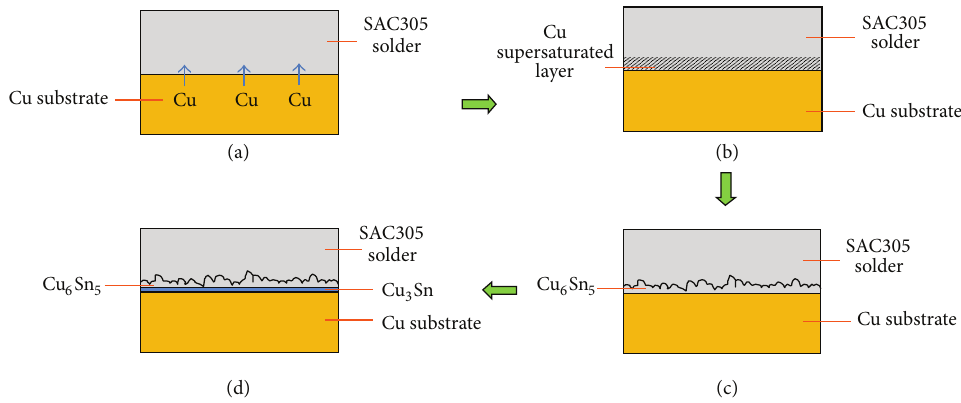
Figure 3: Scheme of the interfacial reaction of SAC305/Cu during solder reflow: (a) dissolution of the Cu substrate, (b) supersaturation of the molten solder layer with Cu, (c) formation of the scallop-type Cu 6 Sn 5 at the interface, and (d) Cu 3 Sn emerges between Cu 6 Sn 5 /Cu with prolonged